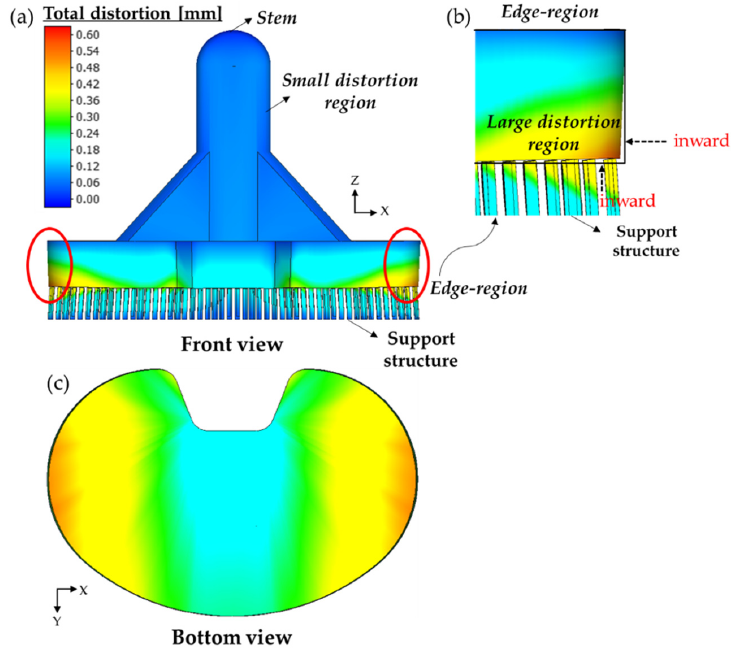
Figure 8. Total distortion distribution of the as-built S-T8 tibial component. ( a ) Front view; ( b ) Amplify the distortion at the edge region; ( c ) Bottom